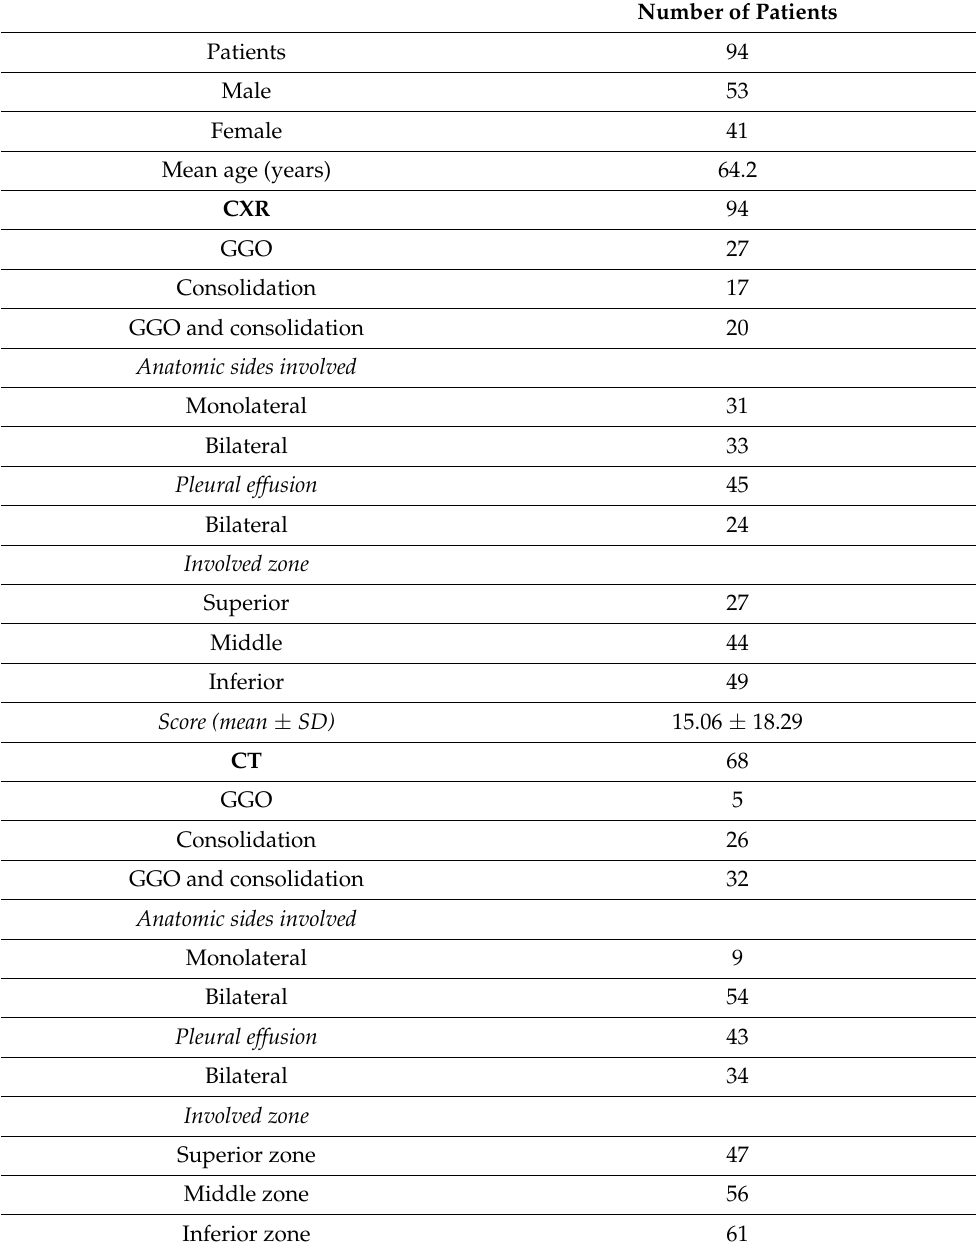
Table 1. Demographic and imaging findings on CXR and CT